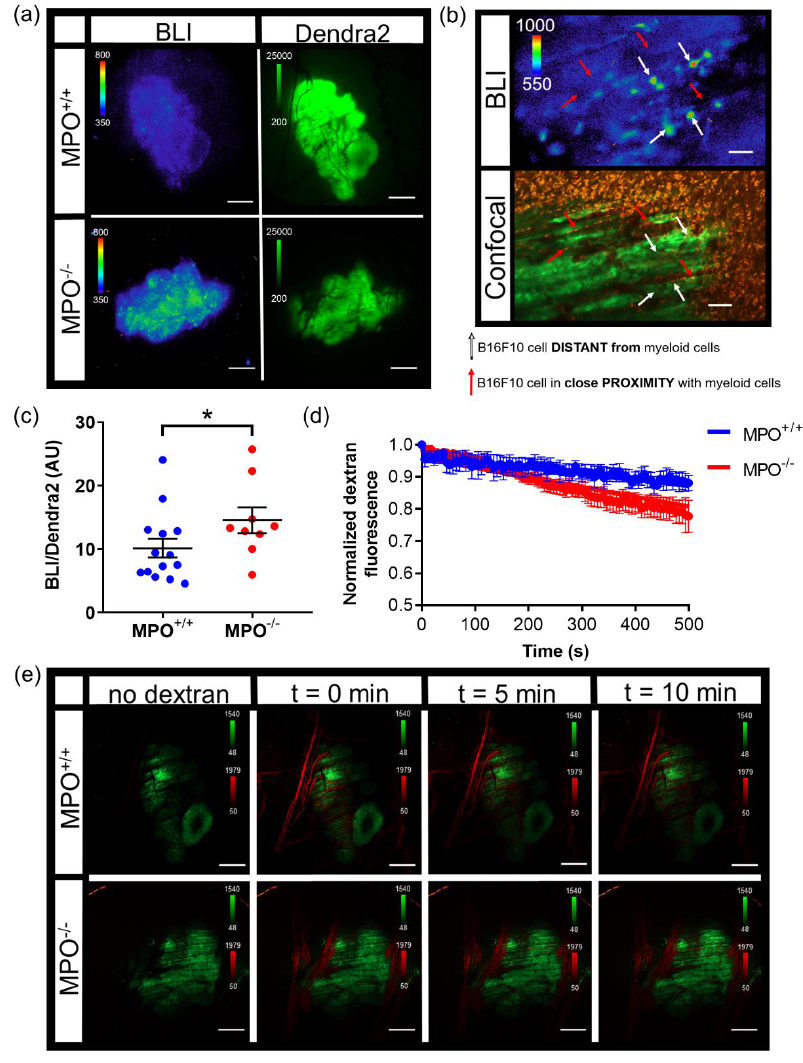
Figure 4. Intravital microscopy of wild type ( MPO +/+ ) and MPO -null ( MPO −/− ) window chamber-bearing animals with B16F10 NF-κB-FLuc Dendra2 melanoma tumors. ( a ) Representative intravital image of NF-κB-FLuc bioluminescence (BLI, 20 min acquisition, open filter) and Dendra2 epifluorescence (GFP cube, 1 s exposure) at 2X in MPO +/+ and MPO −/− animals at day 7 post window chamber implantation and tumor inoculation; scale bar represents 1000 μm. ( b ) Representative high resolution intravital microscopic image of bioluminescence (BLI) and corresponding confocal image of B16F10 NF-κB-FLuc tumor cells (Dendra2; green), myeloid cells (αGr-1+; red, and dextran uptake; orange); red arrows indicate B16F10 cells in contact with myeloid cells, white arrows indicate B16F10 cells not in contact with myeloid cells, 10X objective; scale bar, 100 μm (alternate image of previously reported publication [50] ). ( c ) Quantification of NF-κB-FLuc bioluminescence normalized to tumor Dendra2 fluorescence between day 5 and day 7 post tumor inoculation (data are represented as mean ± SEM, statistical significance calculated by unpaired two-tail Mann–Whitney t test, * p < 0.05, n = 14 MPO +/+ animals, n = 9 MPO −/− animals). ( d ) Quantitative decrease in Texas Red fluorescence corresponding to leakage of dextran from the vasculature of B16F10 tumors over time (data are represented as mean ± SEM, n = 4 animals per group). Dextran leaks out of MPO −/− B16F10 tumor vasculature significantly faster than from MPO +/+ B16F10 tumor vasculature (least squares fit, slope significantly different, p < 0.0001). ( e ) Representative confocal images in MPO +/+ and MPO − / − animals of tumor vasculature post i.v. injection of dextran-Texas Red (70,000 MW, 4 mg/mL) at different time points (green, B16F10 Dendra2 fluorescence; red, dextran-Texas Red); 2X objective, scale bar indicates 1000 µ